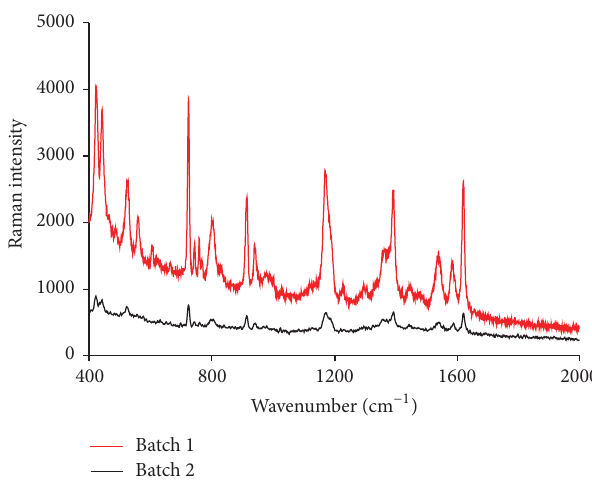
Figure 8: SERS spectra of crystal violet (1mM) from different batches of Au NPs. Batch 1: Au NPs prepared in the presence of 0.075mM KBr. Batch 2: Au NPs prepared in the absence of